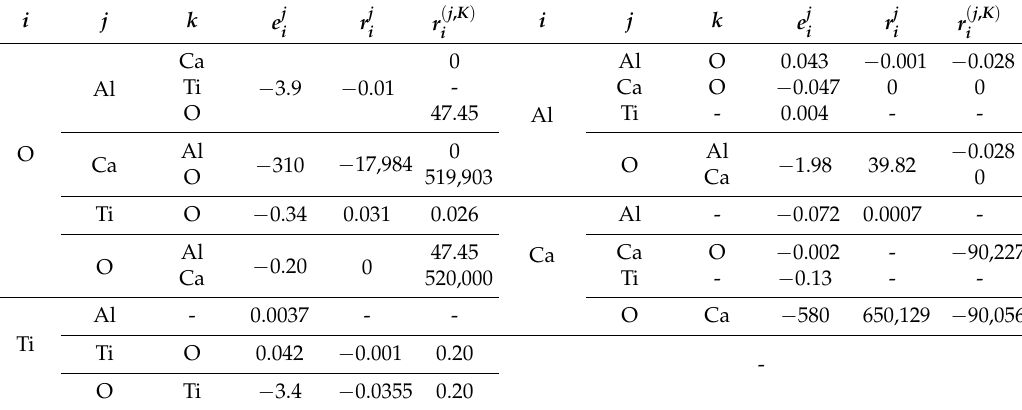
Table 4. The interaction coefficients of Fe–Al–Ti–Ca–O system molten steel at 1873 K [54–69].